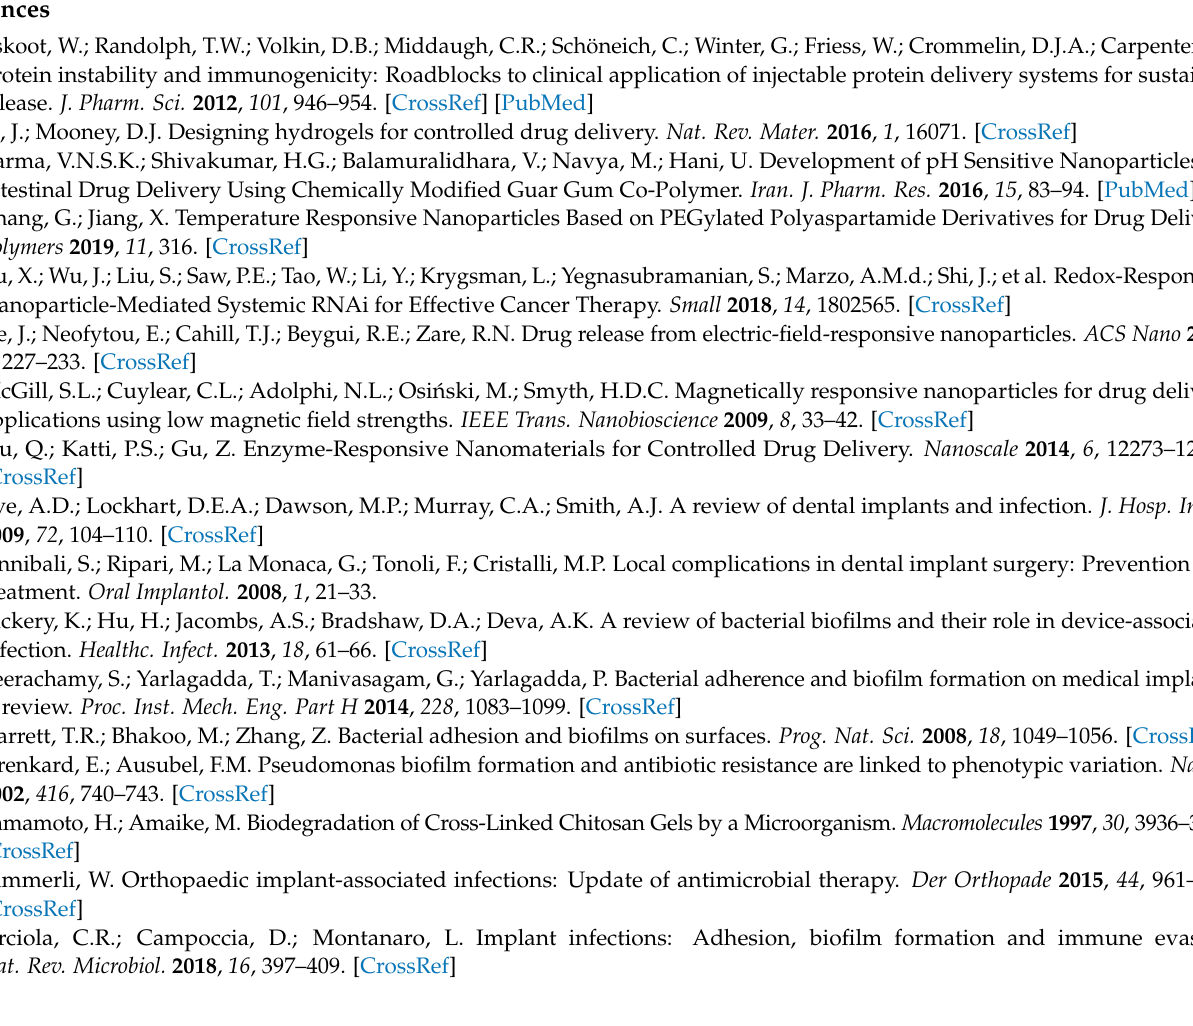
Figure S7: NH-HMBC spectrum of substance 5 in deuterated DMF. Figure S8: 2D-HMBC spectrum of substance 5 in deuterated DMF. Figure S9: FT-IR spectra of PLL 9 -N 3 ( 3 ) and ciprofloxacin-poly- L - lysine ( 4 ). Figure S10: UV-Vis absorbance spectra of ciprofloxacin-L-lysine, substance 5 , substance 6 , and commercial